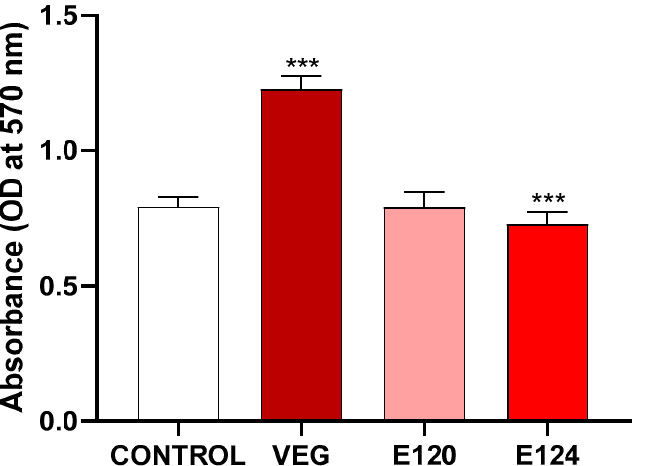
Figure 1. Effect of vegan red VEG, E120, or E124 on PNT1A cell viability. Notice the significant decrease induced by E124 and the significant increase induced by vegan red. (Data are mean ± SEM; *** p < 0.001). The hatching percentage (Figure 2) was significantly decreased in cysts exposed to vegan red ( p < 0.05) or E120 ( p < 0.01), at both 24 and 48 h. In cysts exposed to E124, no significant effect was observed at 24 h, while at 48 h a dramatic increase ( p < 0.001) occurred with the hatching percentage rising to 66.7 ± 6.4 compared to the 17.4 ± 5.0 of control cysts.